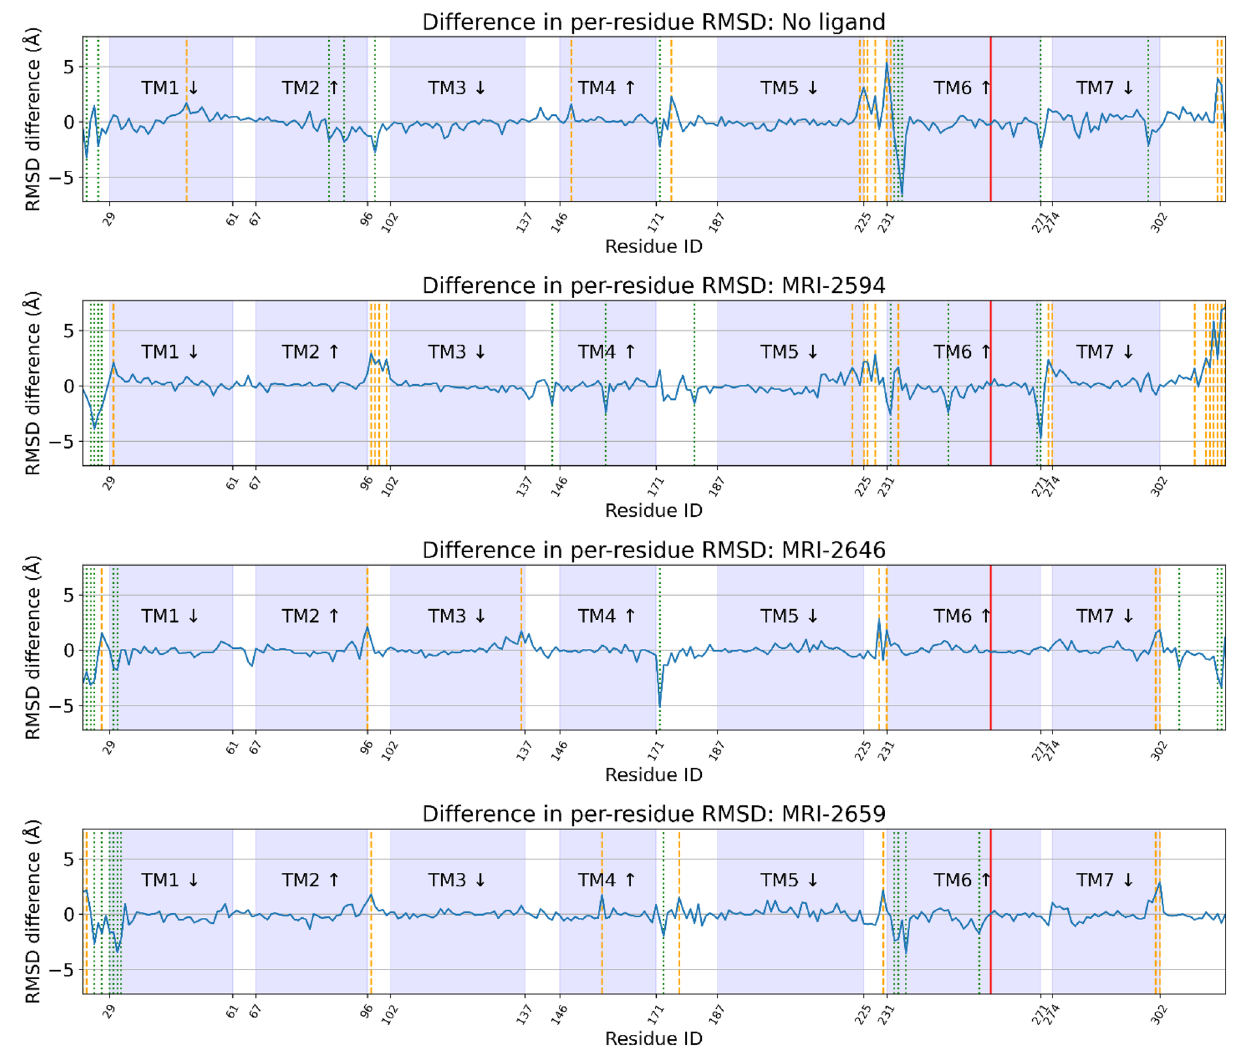
Figure 10. Difference in per-residue root-mean-square deviation (RMSD) between simulation and antagonist- bound cryo-EM structure. Trp258 6.48 highlighted in red, residues with > 1 Å difference highlighted in orange (positive change) or green (negative change) dashed line. TM domains are annotated, with up and down arrows indicating direction of helix, with up from intracellular to